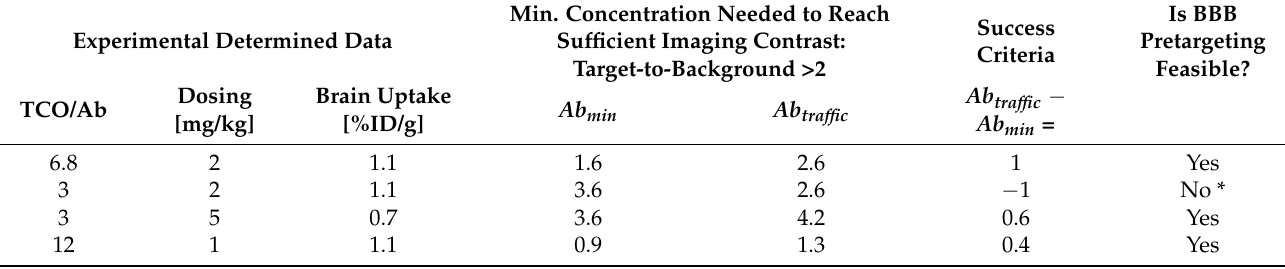
Table 1. A summary of the results. Pretargeting beyond the BBB appears to be feasible as the minimum amount of TCOs required for pretargeted brain imaging can be delivered using the RMT brain delivery of TCO-3D6scFv8D3 (i.e., Ab traffic ≤ Ab min ). An average mouse weight of 25 g was used for the